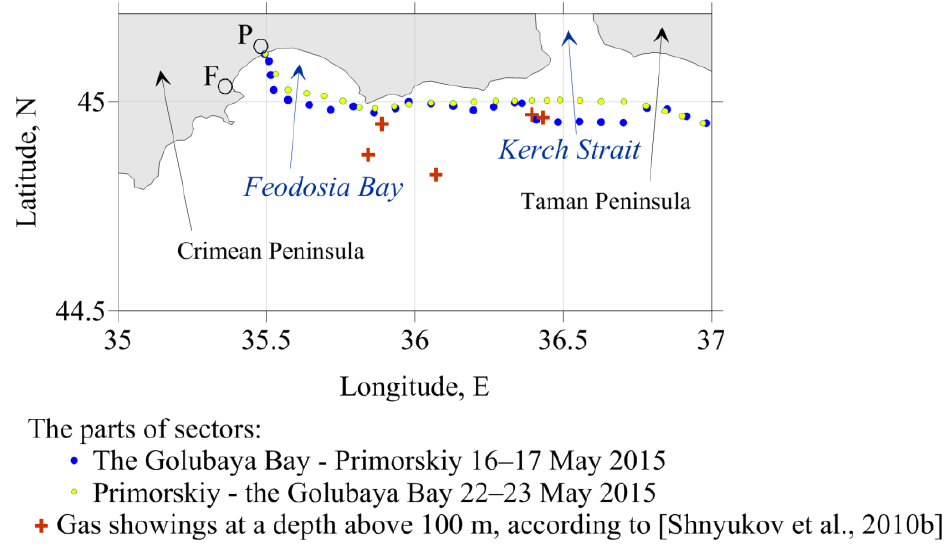
Figure 14. Location of sampling stations on the sections Golubaya Bay–Primorskiy (16–17 May 2015) and Primorskiy–Golubaya Bay (22–23 May 2015) in the Kerch–Taman area, as well as gas seepages at a depth above 100 m. F—Feodosia, P—Primorskiy.